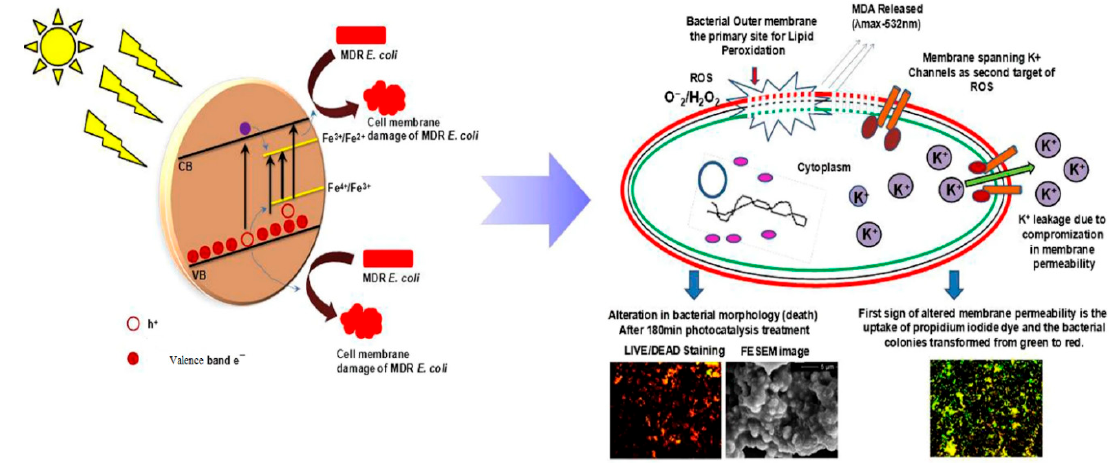
Figure 40. Schematic view of visible-light photocatalytic bactericidal activity of Fe/ZnO NPs against